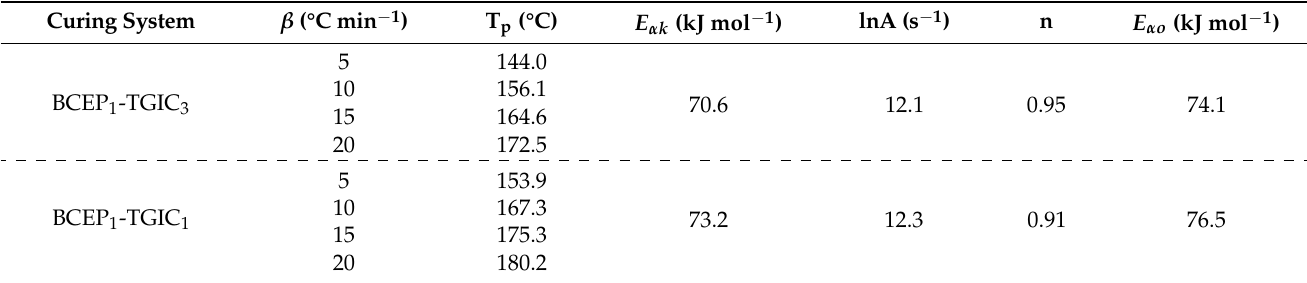
Table 1. Curing kinetic parameters obtained from non-isothermal DSC